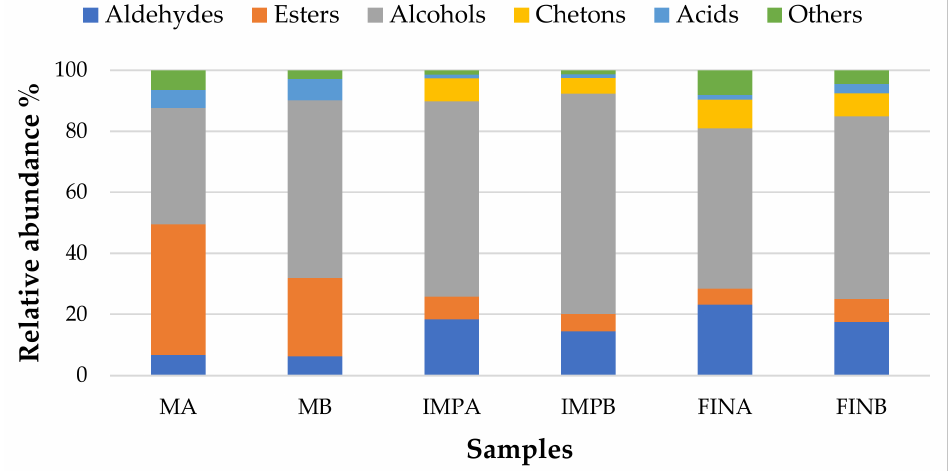
Figure 7. Relative abundance (%) of the chemical classes of volatile organic compounds (VOCs), determined in sourdough and dough samples at different steps of Panettone